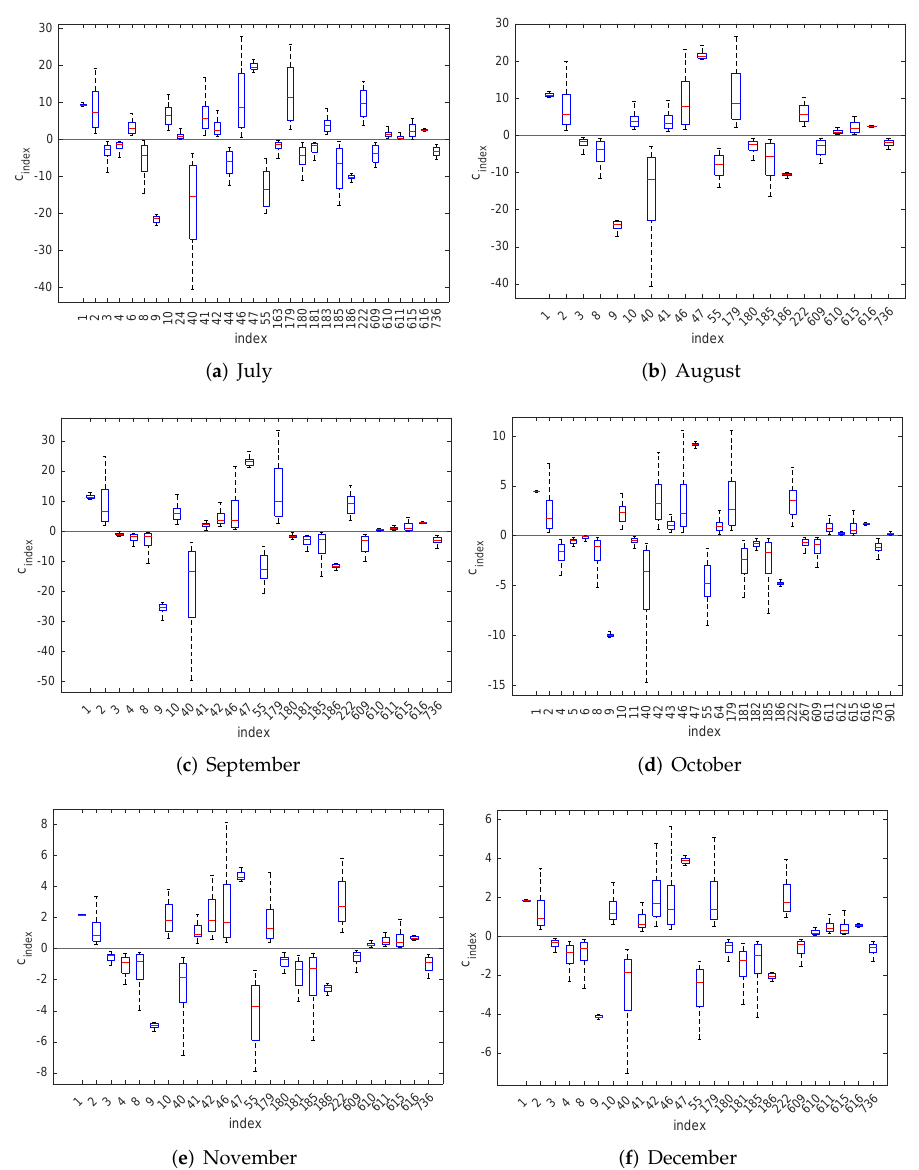
Figure 4. Box-plots of significant posterior PC coefficients: July–December.